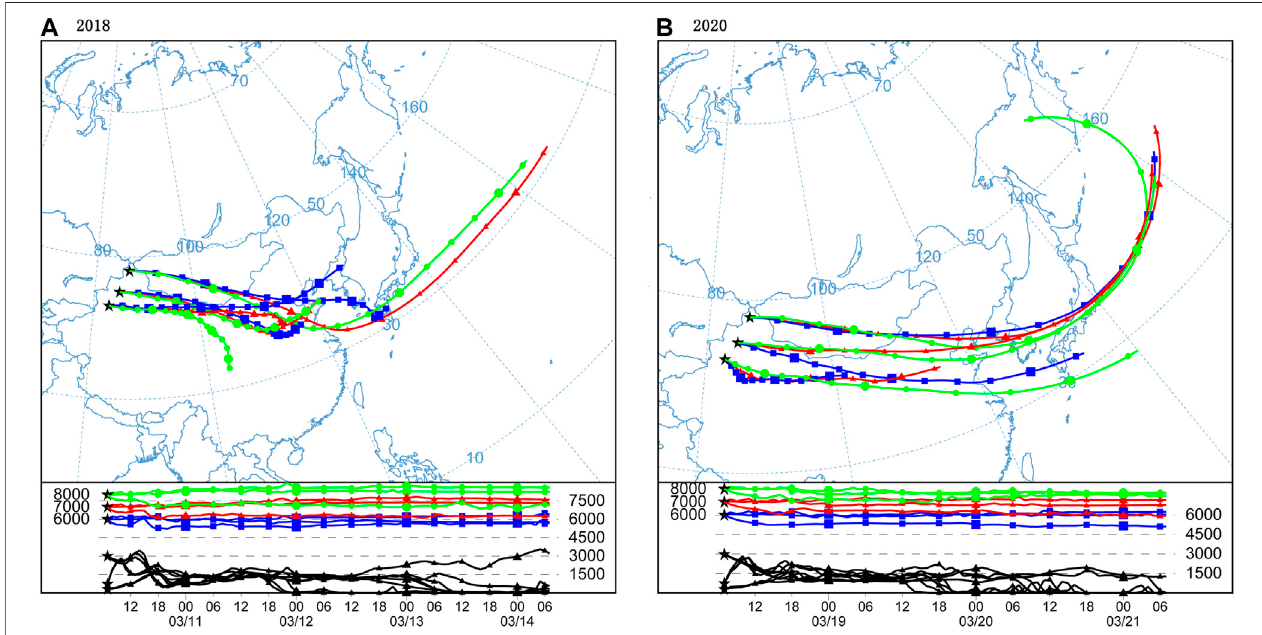
FIGURE1| Distributionofforwardtrajectorieson10thMarch2018 (A) andMarch18,2020 (B) .(Theblue,redandgreencolorsrepresentaltitudesof6,7and8 km above sea level).